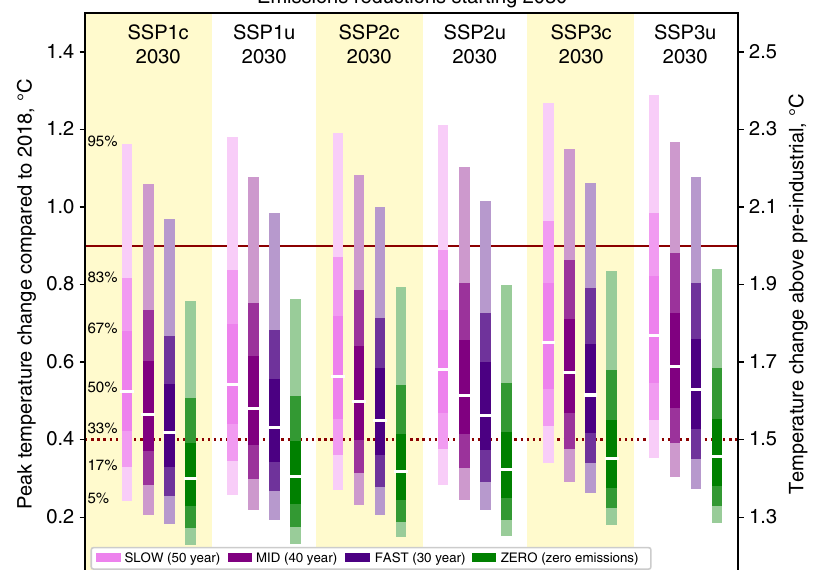
Fig. 3 Peak temperature change compared with 2018 for different rates of fossil fuel phase-out (FAST, MID and SLOW) plus an abrupt cessation of all emissions (ZERO) from 2030. MID scenarios assume a phase-out of fossil fuel infrastructure based on historical generator lifetimes 13 . FAST and SLOW cases vary these lifetimes by subtracting and adding 10 years, respectively. Shown are results from SSP1, SSP2 and SSP3 with for conditional (c) and unconditional (u) NDCs based on socioeconomic developments under SSP1, SSP2 and SSP3. Supplementary Figure 8 shows the corresponding ranges for 2100 temperatures. SSP2c-2030-MID and SSP2c-2030-ZERO are consistent with infrastructure and zero emissions commitments in Fig. 1b